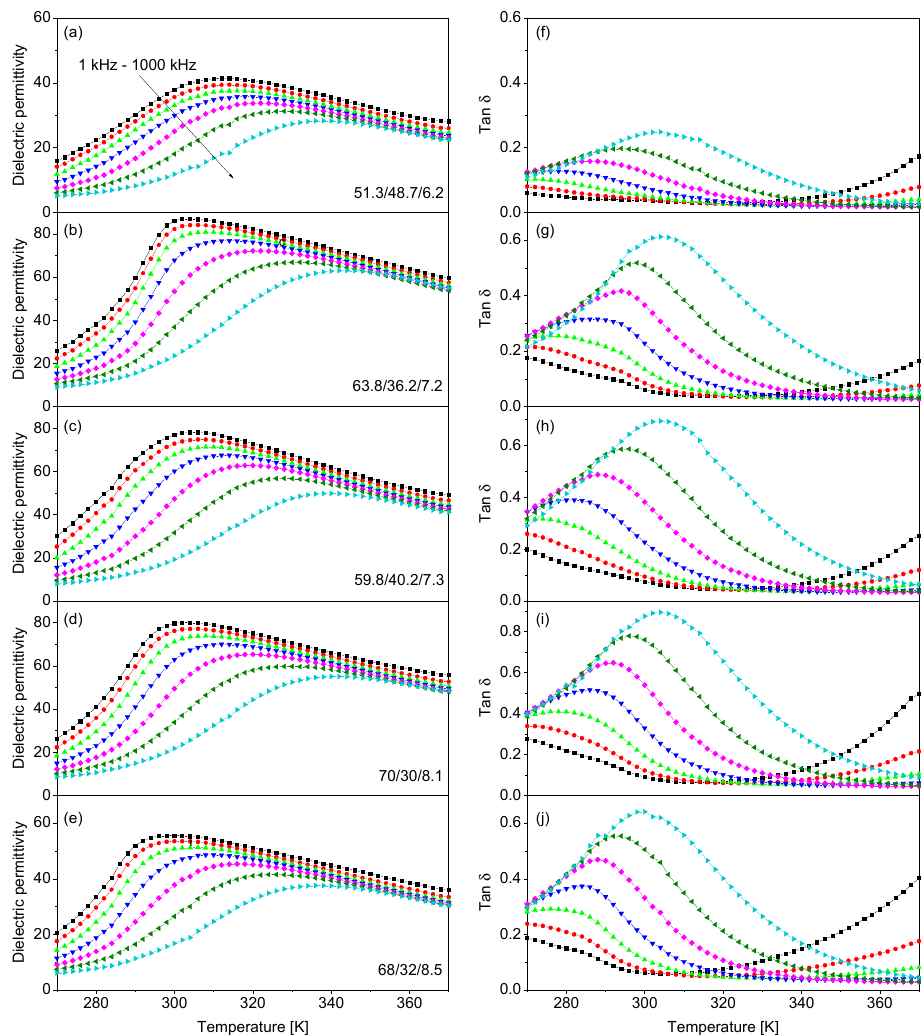
Figure 2. Temperature dependence of the dielectric permittivity ( a – e ) and dielectric loss tangent ( f – j ) of P(VDF x -TrFE 1-x -CFE y ) films measured at frequencies from 1 kHz to 1 MHz upon cooling. Table 3. Parameters describing the relaxor behavior of the studied the P(VDF x -TrFE 1-x -CFE y ) films. Fitting Parameters for P(VDF x -TrFE 1-x -CFE y ) Fitting Parameters for the P(VDF x -TrFE 1-x -CFE y ) Degree of Relaxor Freezing Tempera- (mol. %) Vogel-Fulcher Equation (mol. %) Behavior, γ ture, T f (K) ln (f 0 )